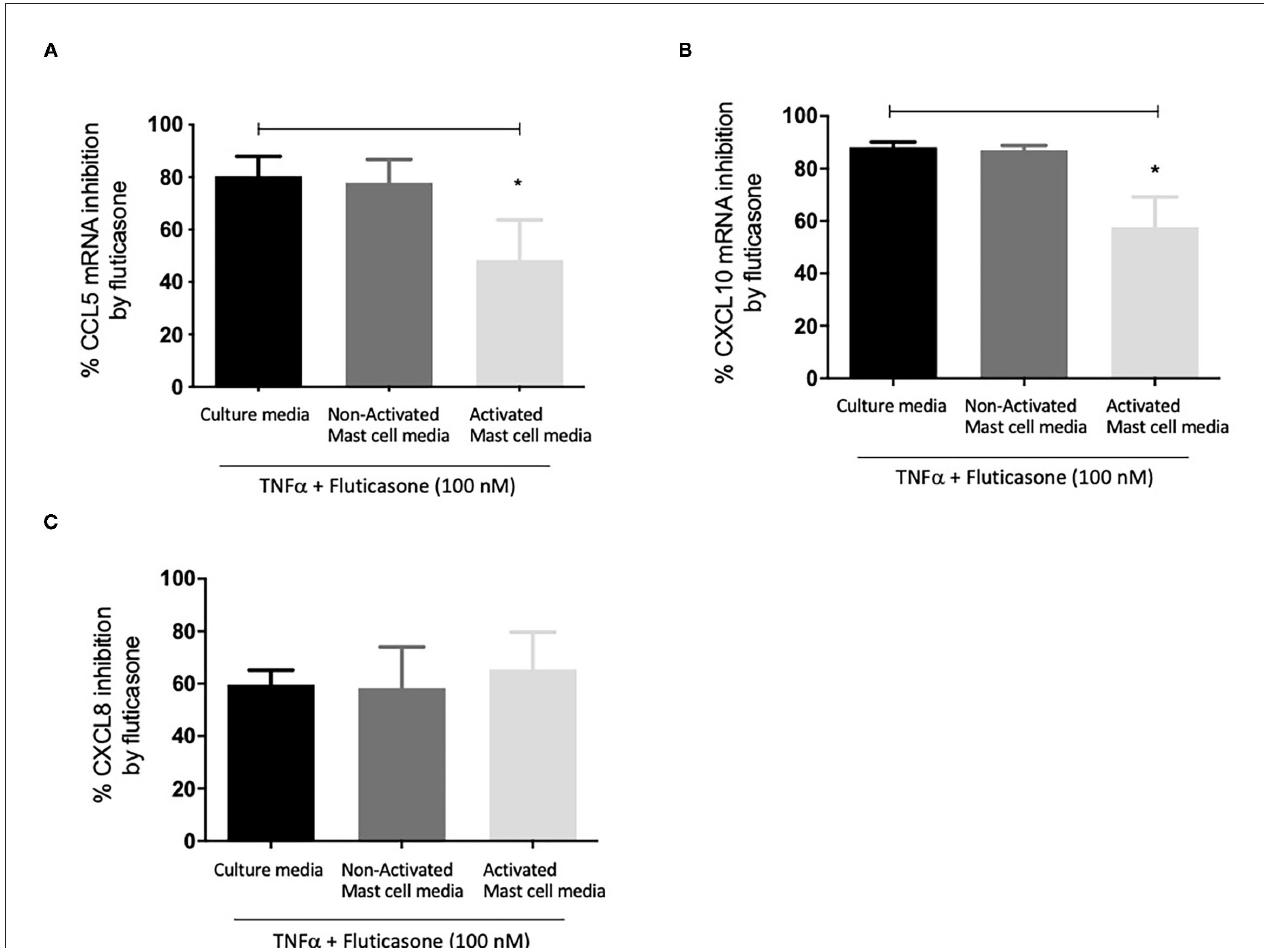
FIGURE 3 | Inhibition of TNF α -induced chemokine mRNA expression by fluticasone in ASM cells pre-treated with conditioned media from 24-h activated mast cells. Healthy ASM cells were pre-treated with control mast cell media, conditioned media from 24-h non-activated, or 24-h activated mast cells for 24h. ASM cells were then washed and stimulated with 10ng/ml TNF- α with or without 100nM fluticasone for 8h. Chemokine expression of CCL5 (A) , CXCL10 (B) , and CXCL8 (C) was assessed by real-time PCR. Data are presented as % inhibition from chemokine responses in cells treated with TNF α alone (Means ± SEM of n = 5 different cell lines, * p < 0.05). Comparisons between groups were made using one-way ANOVA and Tukey Test